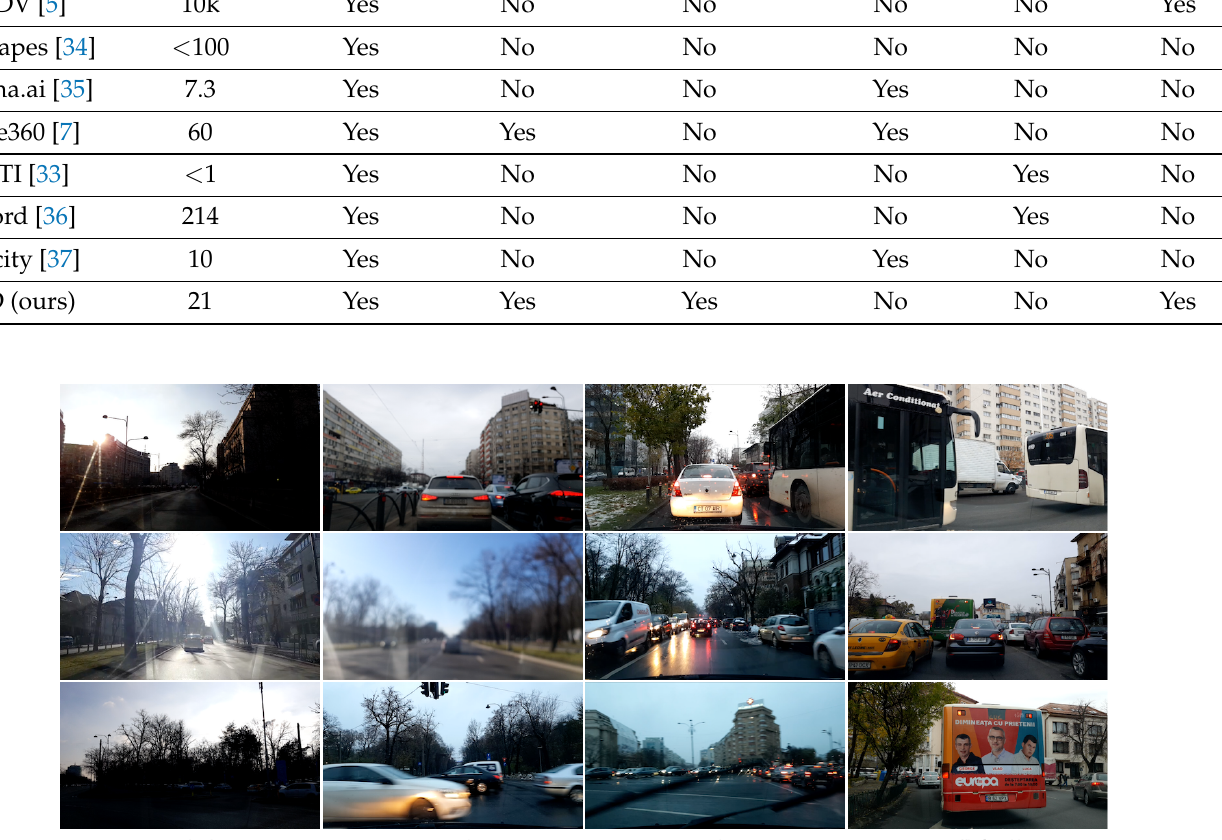
Table 1. Comparison of real-world driving datasets for imitation learning. Dataset Planner Route Planner Reader Setup